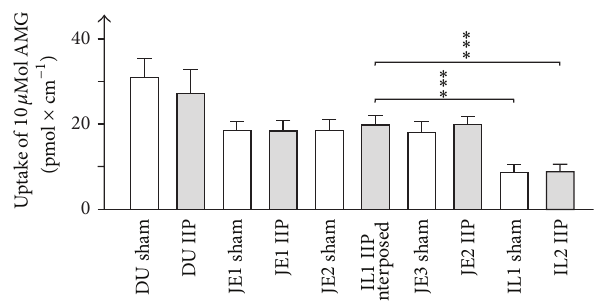
Figure 6: SGLT1-mediated glucose uptake in small intestinal segments of rats on HFD with STZ-induced diabetes after sham operation (open columns) or IIP surgery (closed columns). Sham operation or IIP was performed in the 13th week of life and the ex vivo uptake measurements were performed in the 18th week of life. Uptake of 10 𝜇 M [ 14 C]AMG inhibited by 200 𝜇 M phlorizin was measured in everted small intestinal segments obtained from the regions indicated in Figure 1(a). Mean values ± SEM from 6 animals are indicated. ∗∗∗ 𝑝 < 0.001